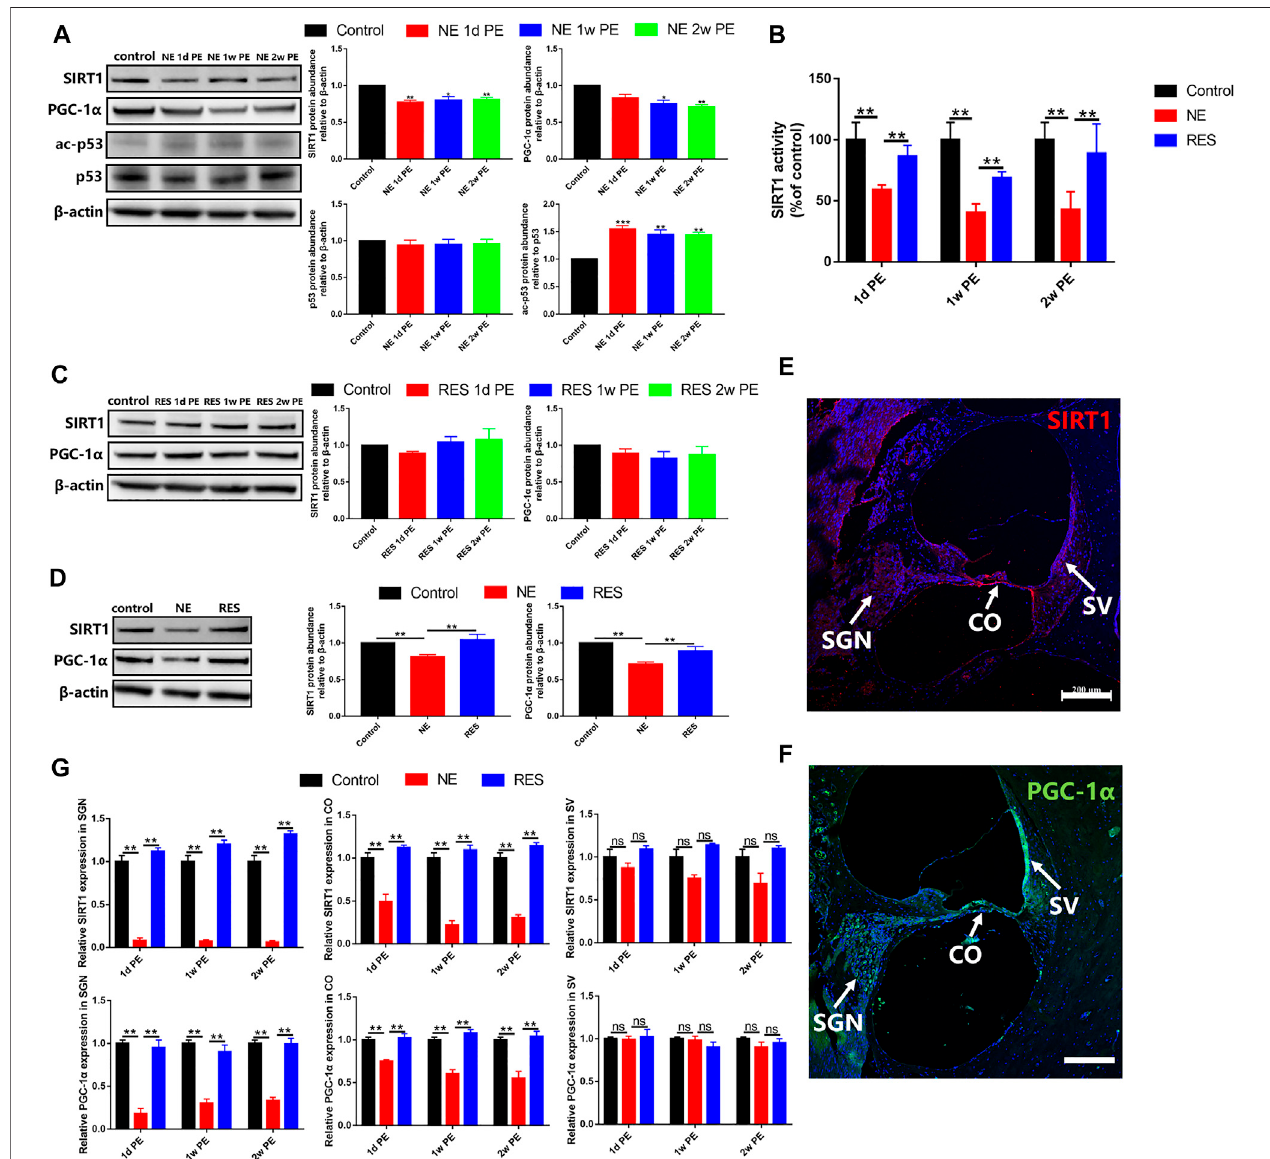
FIGURE 4 | SIRT1, p53 and PGC-1 α after noise exposure, the values are presented as the means ± SEM. (A) The protein levels of SIRT1 (130 kDa), PGC-1 α (110 kDa), p53 (53 kDa) and acetylation of p53 after noise exposure in the NE group. (B) SIRT1 activity was measured based on an enzymatic reaction using a SIRT1 assay kit. (C) The protein levels of SIRT1 (130 kDa), PGC-1 α (110 kDa) after noise exposure in the RES group. (D) The comparison among the control group, NE group and RES group at the aspect of the protein levels of SIRT1 (130 kDa), PGC-1 α (110 kDa). (E) The expression of SIRT1 in the cochleae of guinea pigs in the control group. Scale bar = 200 µm. SV: stria vascularis, CO: Corti ’ s organ, SGN: spiral ganglion neuron. Red is used to mark the expression of SIRT1, and blue is used to mark the nucleus. (F) The expression of PGC-1 α in the cochleae of guinea pigs in the control group. Scale bar = 200 µm. SV: stria vascularis, CO: Corti ’ s organ, SGN: spiral ganglion neuron. Green is used to mark the expression of PGC-1 α , and blue is used to mark the nucleus. (G) The comparison among the control group, NE group and RES group at the aspect of the expression of SIRT1 and PGC-1 α in cochlea by immunolabeling. SV: stria vascularis, CO: Corti ’ s organ, SGN: spiral ganglion neuron. Note: In (A) – (D) ,n=3from3animalsineach group,bothcochleaeofthesame guineapigasasample.In (G), n=6from3animalsineachgroup.In (A) ,* p < 0.05,** p < 0.01, *** p < 0.001, as compared with control group.